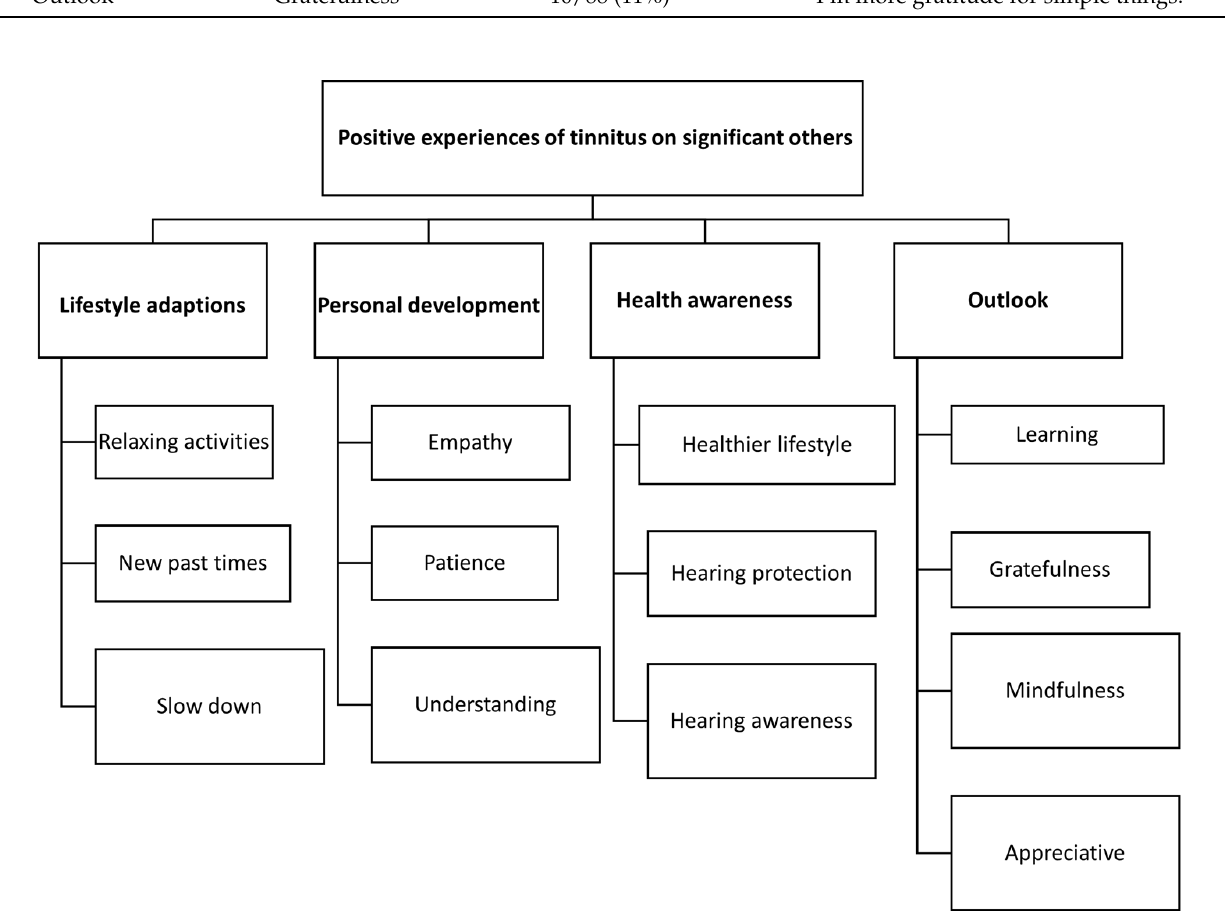
Figure 3. Positive experiences of tinnitus on significant others.